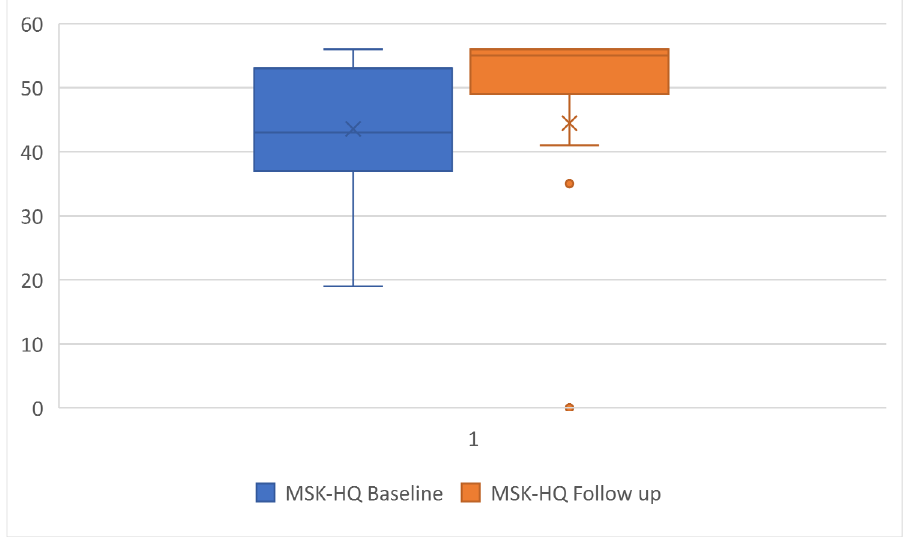
Figure 2. Boxplot of mean and SD for Musculoskeletal Health Questionnaire (MSK-HQ) scores at baseline and follow-up.